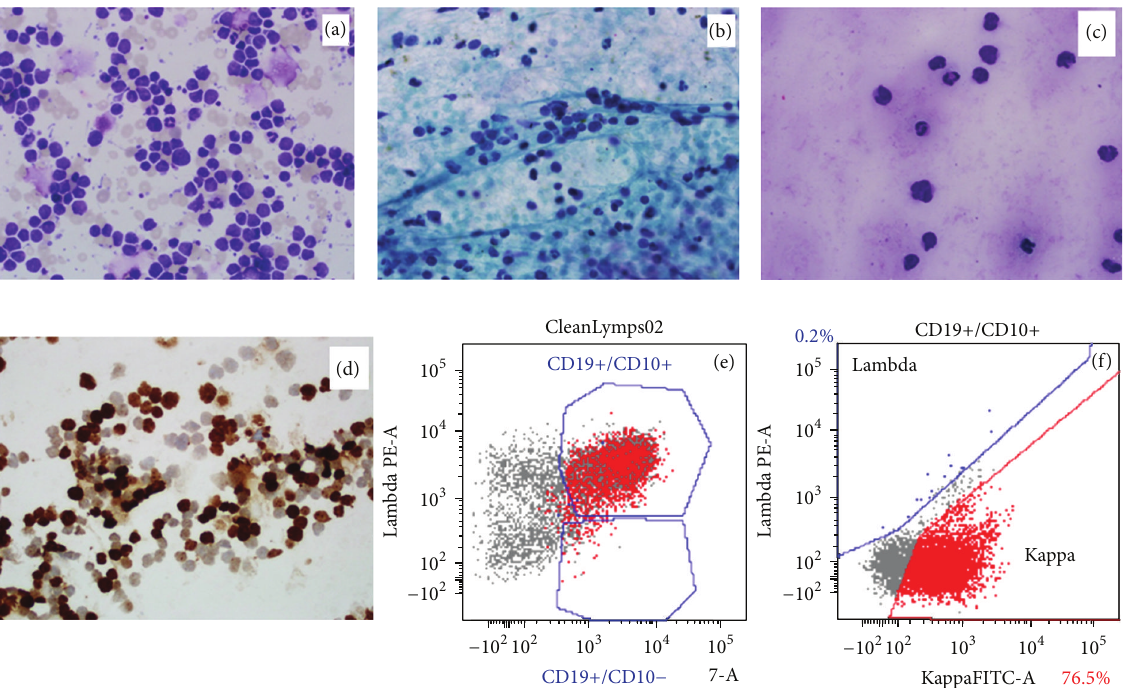
Figure 3: Fine needle aspirate of the cervical mass showed large atypical lymphoid cells in a background of extensive necrosis ((a)–(c)). Representative cytospin (a), aspirate smears Pap stain (b), diff quick stain (c) showing large atypical lymphoid cells with irregular nuclear outlines are shown. Immunoperoxidase stains performed on the cytospins show high Ki-67 proliferation index (d). Immunophenotyping by flow cytometric analysis demonstrates a population of monotypic B-cells expressing CD19, CD10 (e), monotypic kappa light chain (f), and CD38. They are negative for CD5, CD200, CD22, CD43, CD11c, CD23, CD79b, and CD30.